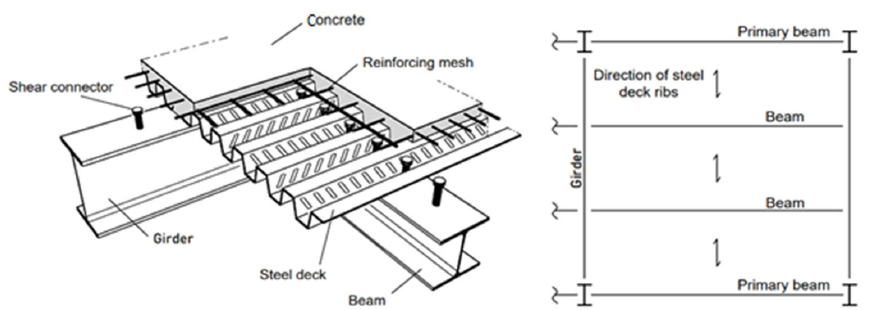
Figure 1. Composite floor with steel profiled sheeting (Adapted from Crisinel and Marimon